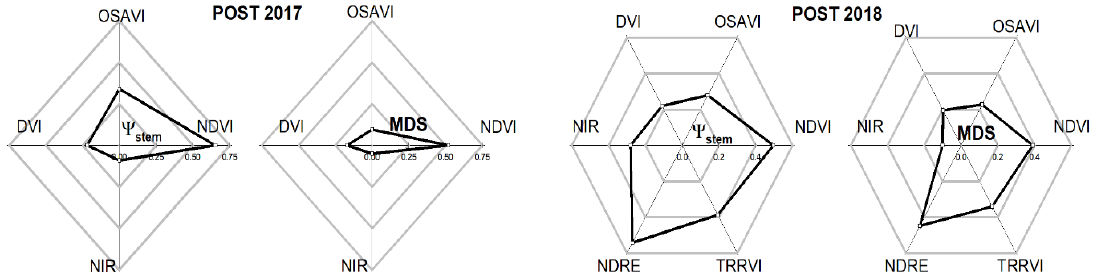
Figure 6. Coefficients of determination obtained from linear relationships between Ψ s (midday stem water potential) and MDS (maximum daily branch shrinkage) with NDVI, OSAVI, DVI, NDRE, TRRVI, and NIR in 2017 and 2018 postharvest.